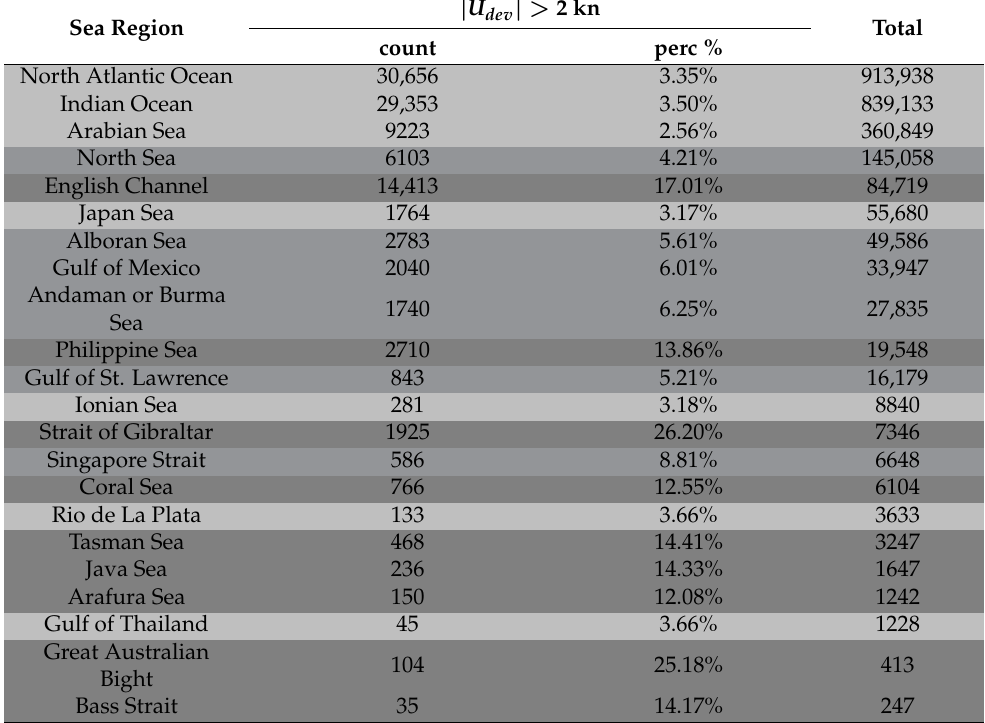
Table 12. Speed deviation U dev above 2 kn boundary decomposed by sea name where the ships have been sailing. Only those seas where the percentage column is greater than 2.47% have been included. Gray background gets darker when the percentage column of | U dev | > 2 kn increases.